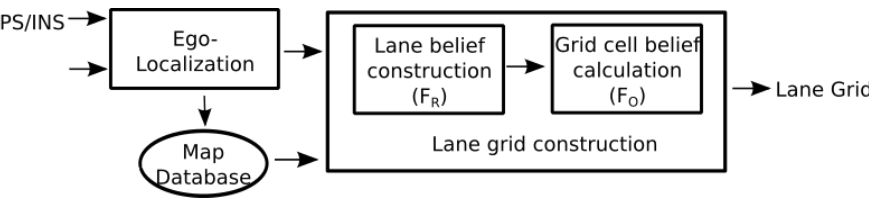
Figure 2. Lane Grid construction